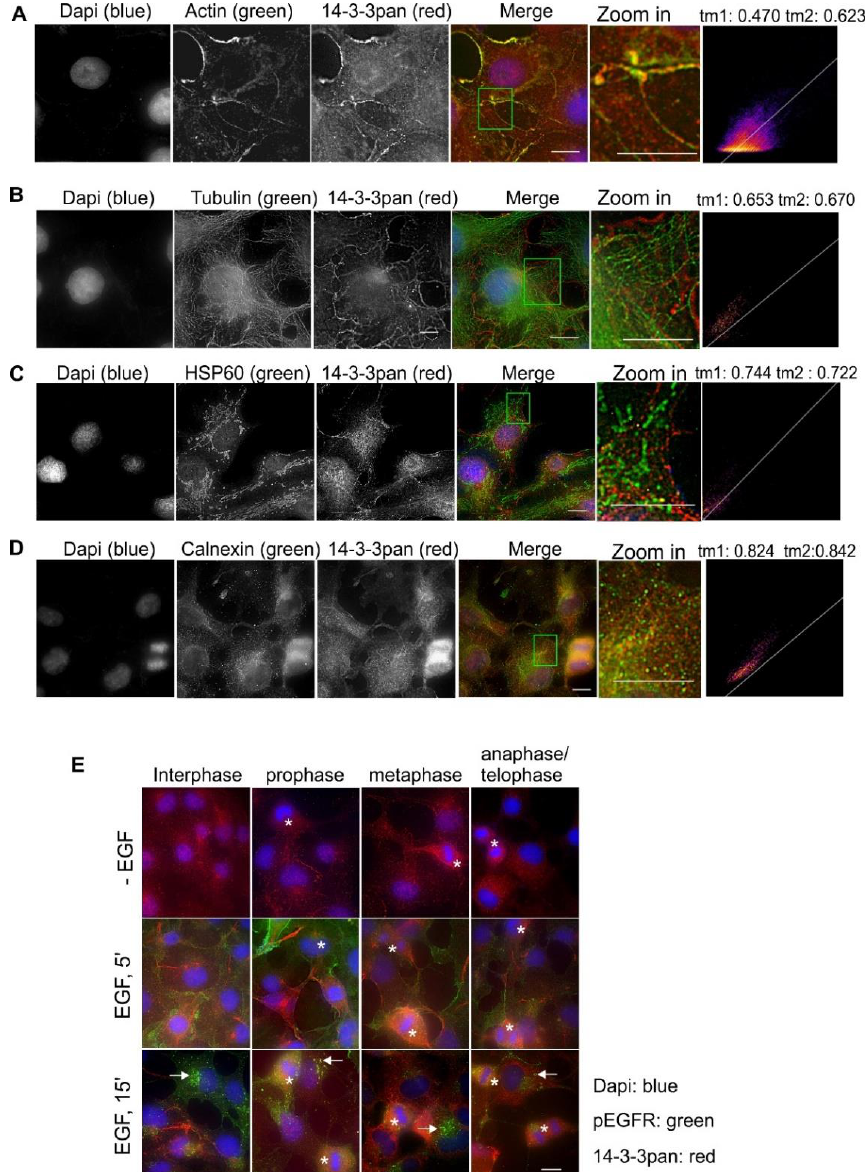
Figure 3. Subcellular localization of the pan14-3-3 protein in Cos-7 cells by double indirect immunofluorescence. ( A ) Co-localization of pan14-3-3 (red) and actin (green); ( B ) co-localization of pan14-3-3 protein (red) and tubulin (green); ( C ) co-localization of pan14-3-3 protein (red) and HSP60 (green); ( D ) co-localization of pan14-3-3 protein (red) and calnexin (green). For ( A – D ), the zoomed-in areas were used to calculate Mander’s coefficients. ( E ) Subcellular localization of pan14-3-3 protein during the cell cycle and in response to EGF. With or without EGF stimulation, pan14-3-3 proteins (red) and pEGFR (green) were revealed by double indirect immunofluorescence. Mitotic cells are labeled by * and endosomes are marked by arrows. Scale bar = 10 μm.